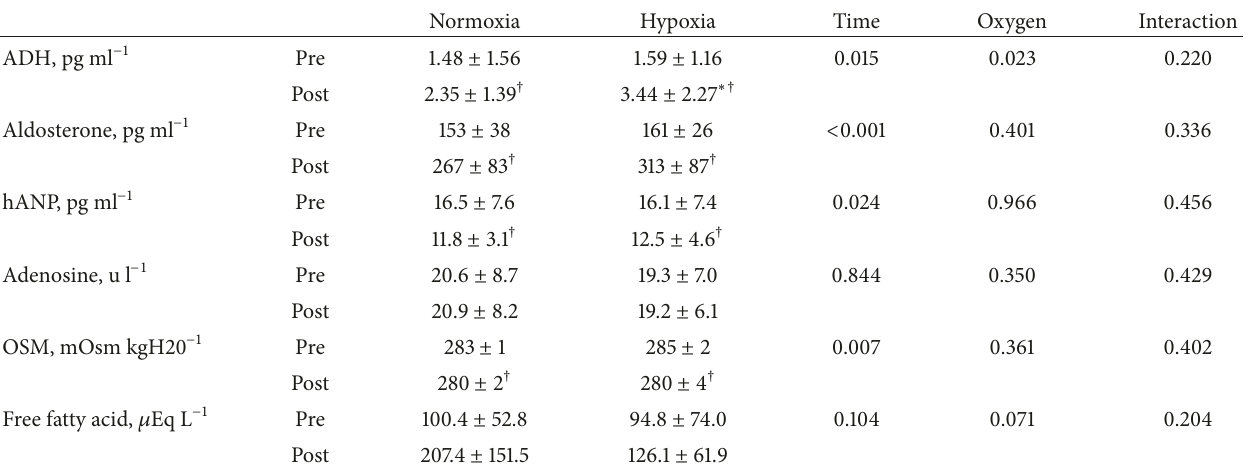
Table 1: Blood biomarkers between pre- and poststudy in two different oxygen conditions.